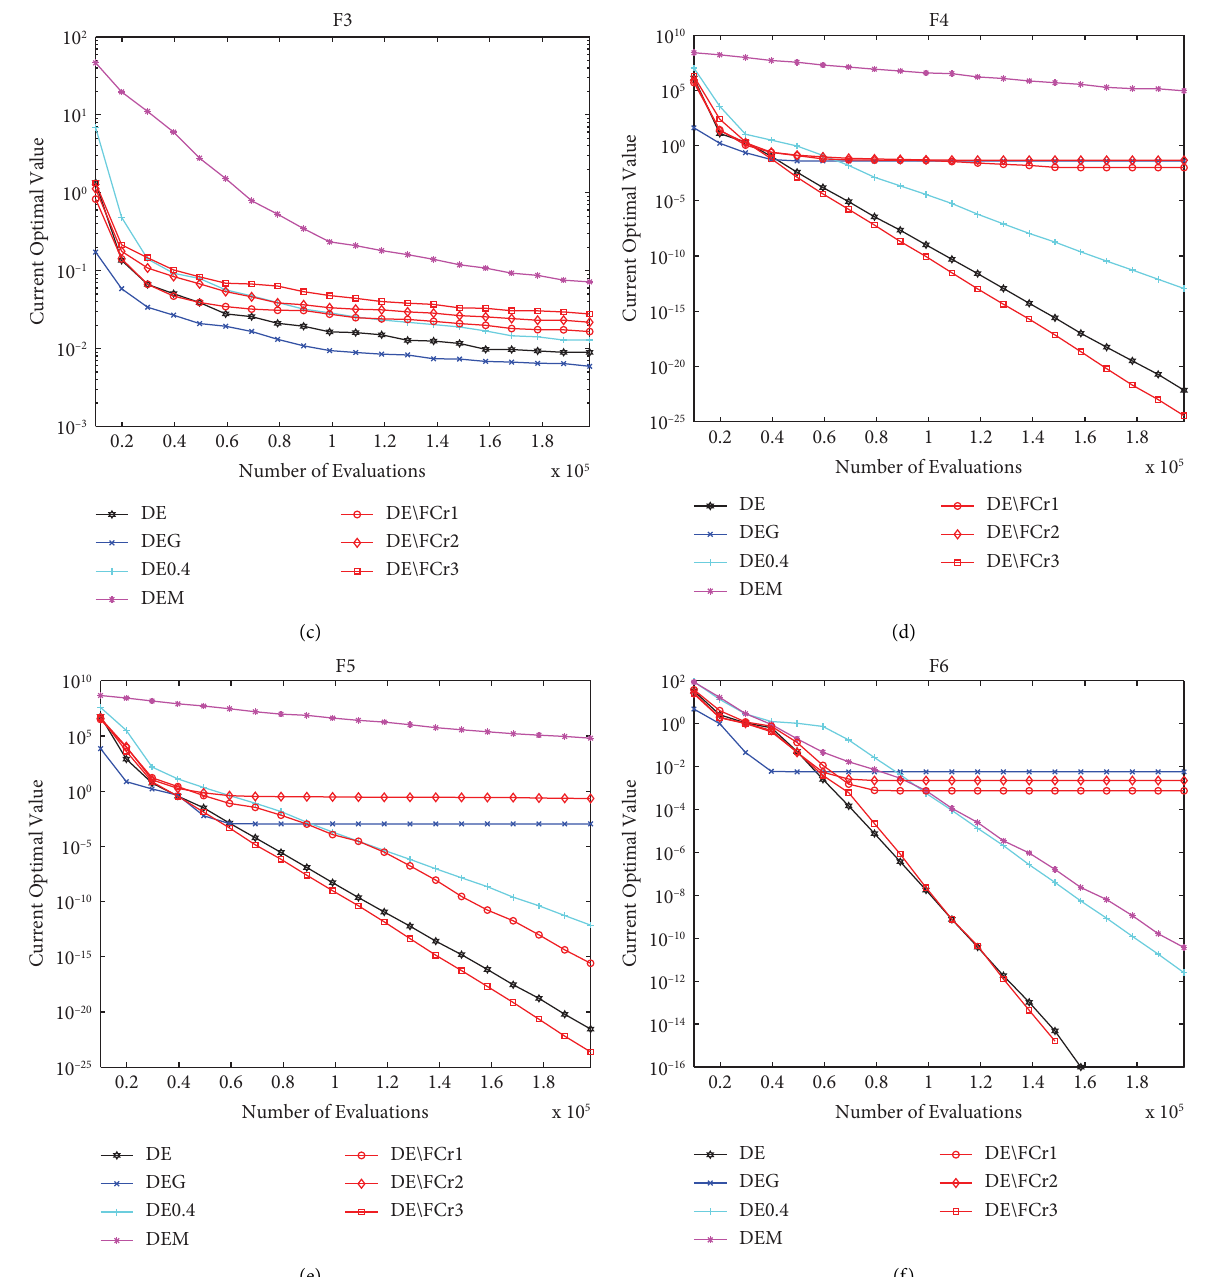
Figure 5: Te mean of the current optimal values obtained by 7 algorithms with the number of function evaluations for F 1– F 6. (a) F 1. (b) F 2. (c) F 3. (d) F 4. (e) F 5. (f) F